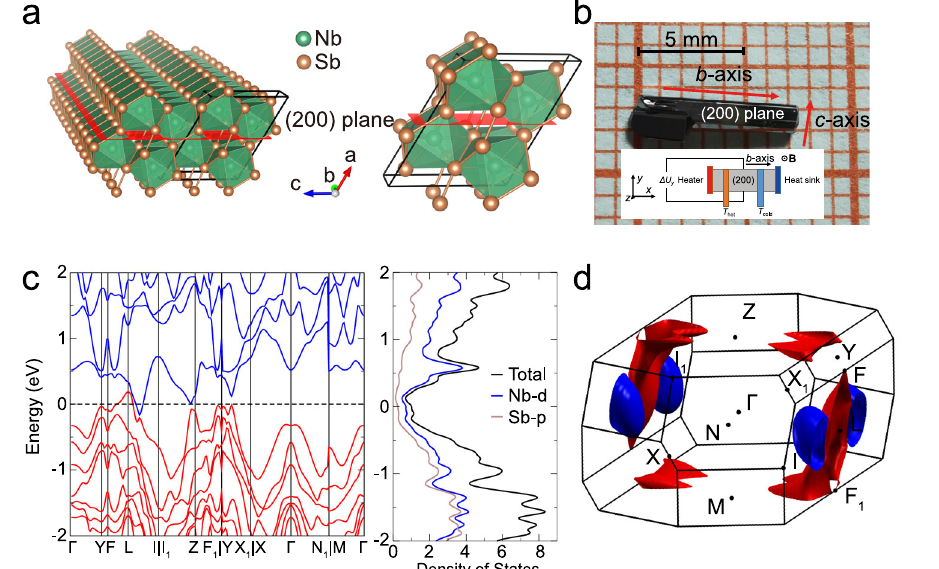
Fig. 2 | Crystal structure and band structure of NbSb 2 . a Crystal structure of NbSb 2 fromdifferentperspectives. b OpticalimageofNbSb 2 singlecrystalgrownin thiswork.TheinsetshowsthemeasurementdirectionoftheNernstthermopower.